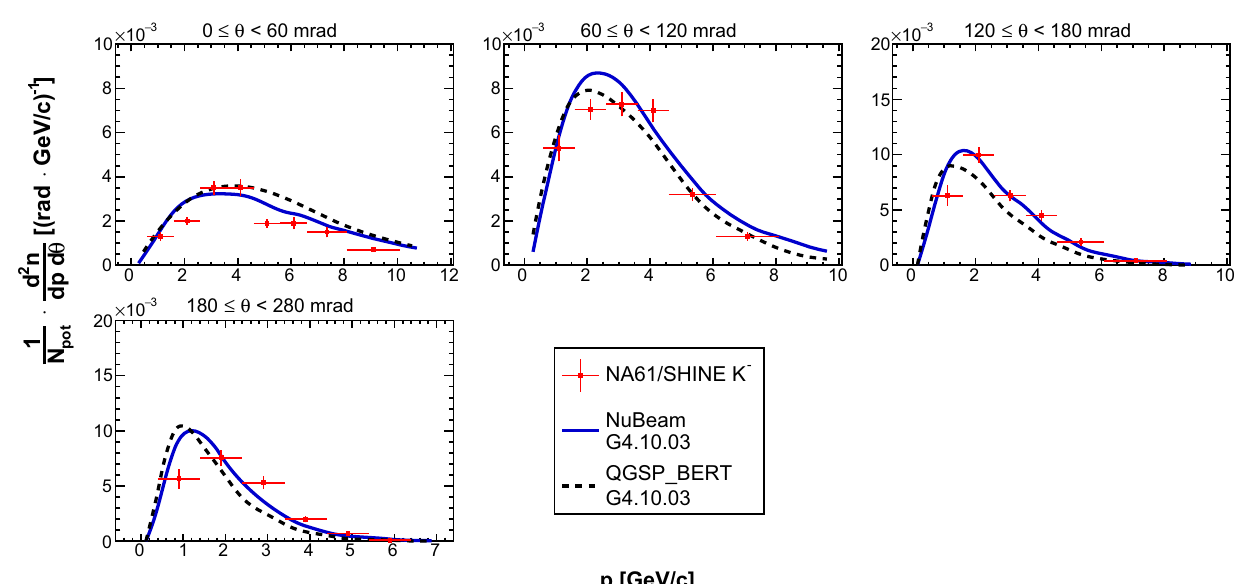
Fig. 44 Double differential yields of negatively charged kaons for the fourth upstream longitudinal bin (54 ≤ z < 72 cm). Vertical bars represent the total uncertanties. Predictions from the NuBeam (solid